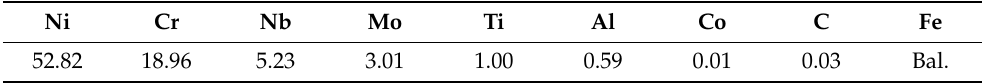
Table 1. The primary chemical compositions (wt. %) of GH4169 superalloy. Ni Cr Nb Mo Ti Al Co C Fe 52.82 18.96